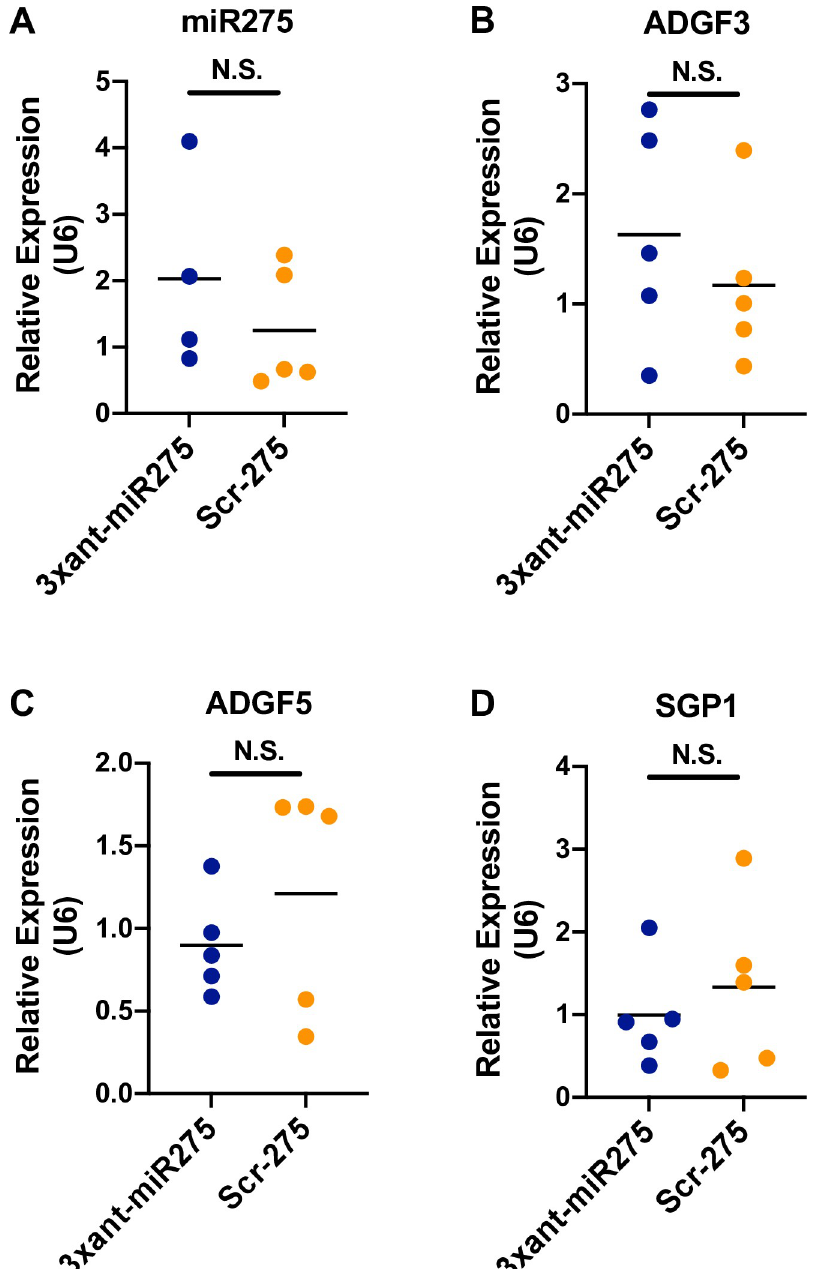
Fig 7. Paratransgenic knockdown of tsetse miR275 expression is not observed in the fly’s salivary glands. (A) miR275 , (B) Adgf 3, (C) Adgf 5 and (D) SGP 1 expression levels in the salivary glands (SGs) of Gmm 3xant- miR275 versus Gmm Scr-275 flies. Each dot represents 10 individual SGs. Student’s t-test was used to determine statistical significance.